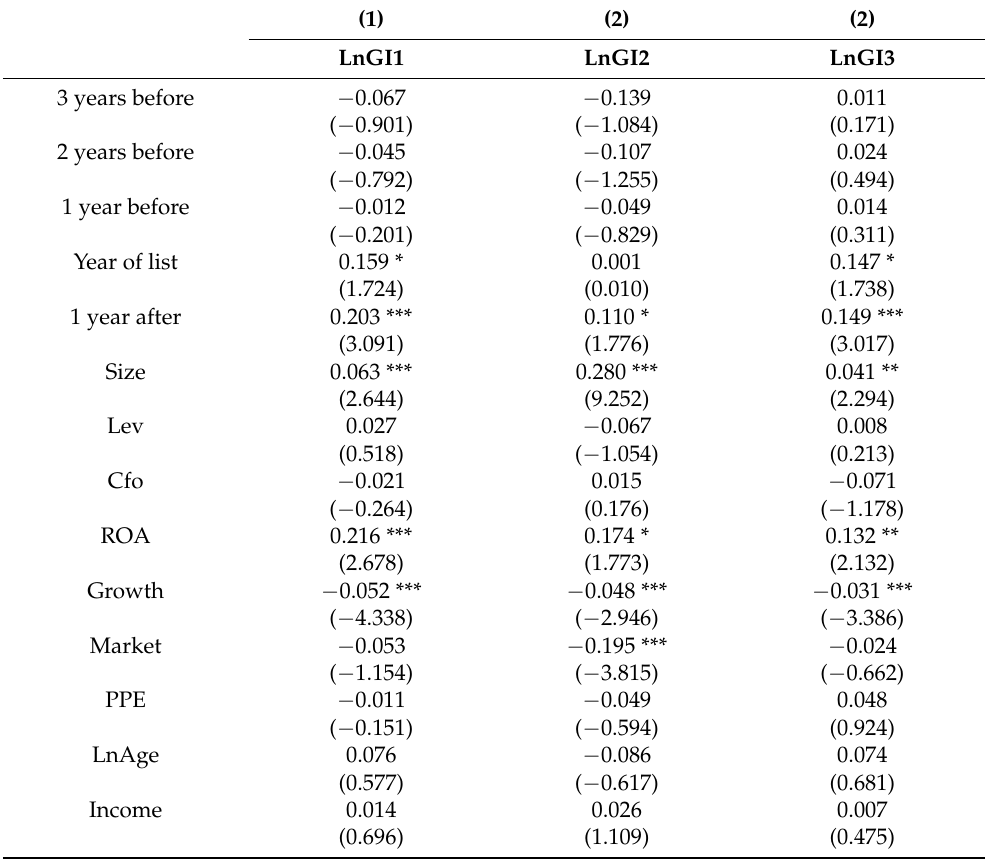
Table 4. The results of the parallel trend